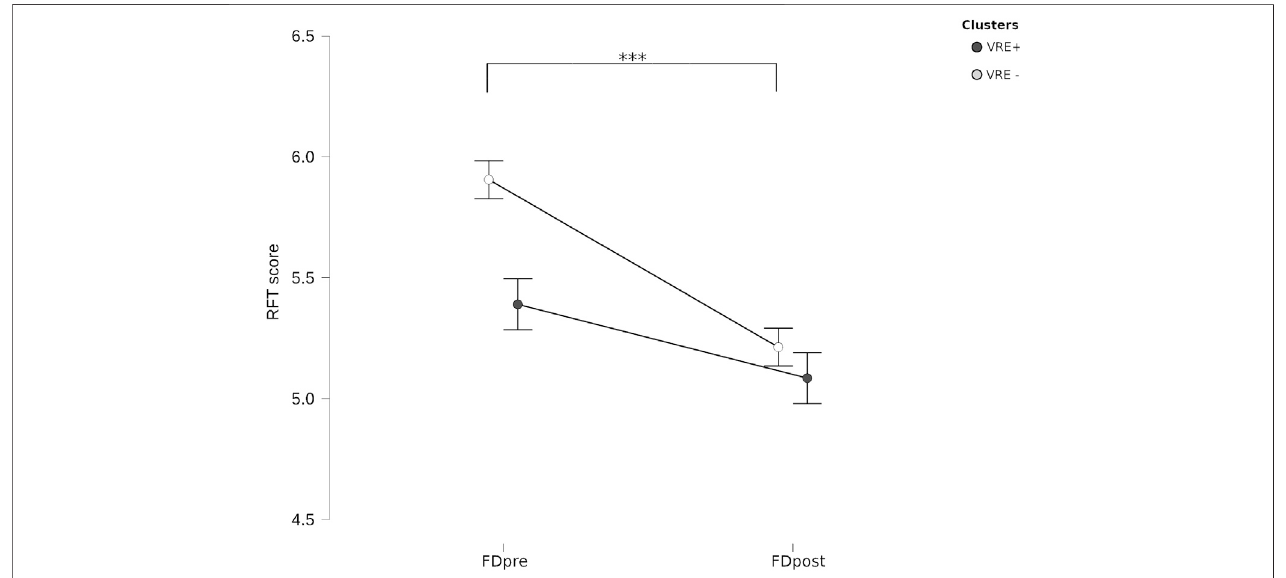
FIGURE4| MeanRFT(rod-and-frametest)scoresandstandarderrorsofFDbefore(FDpre)andafter(FDpost)VRimmersionineachVRnexperiencecluster(VRE+ and VRE - ). ***: p < 0.001.